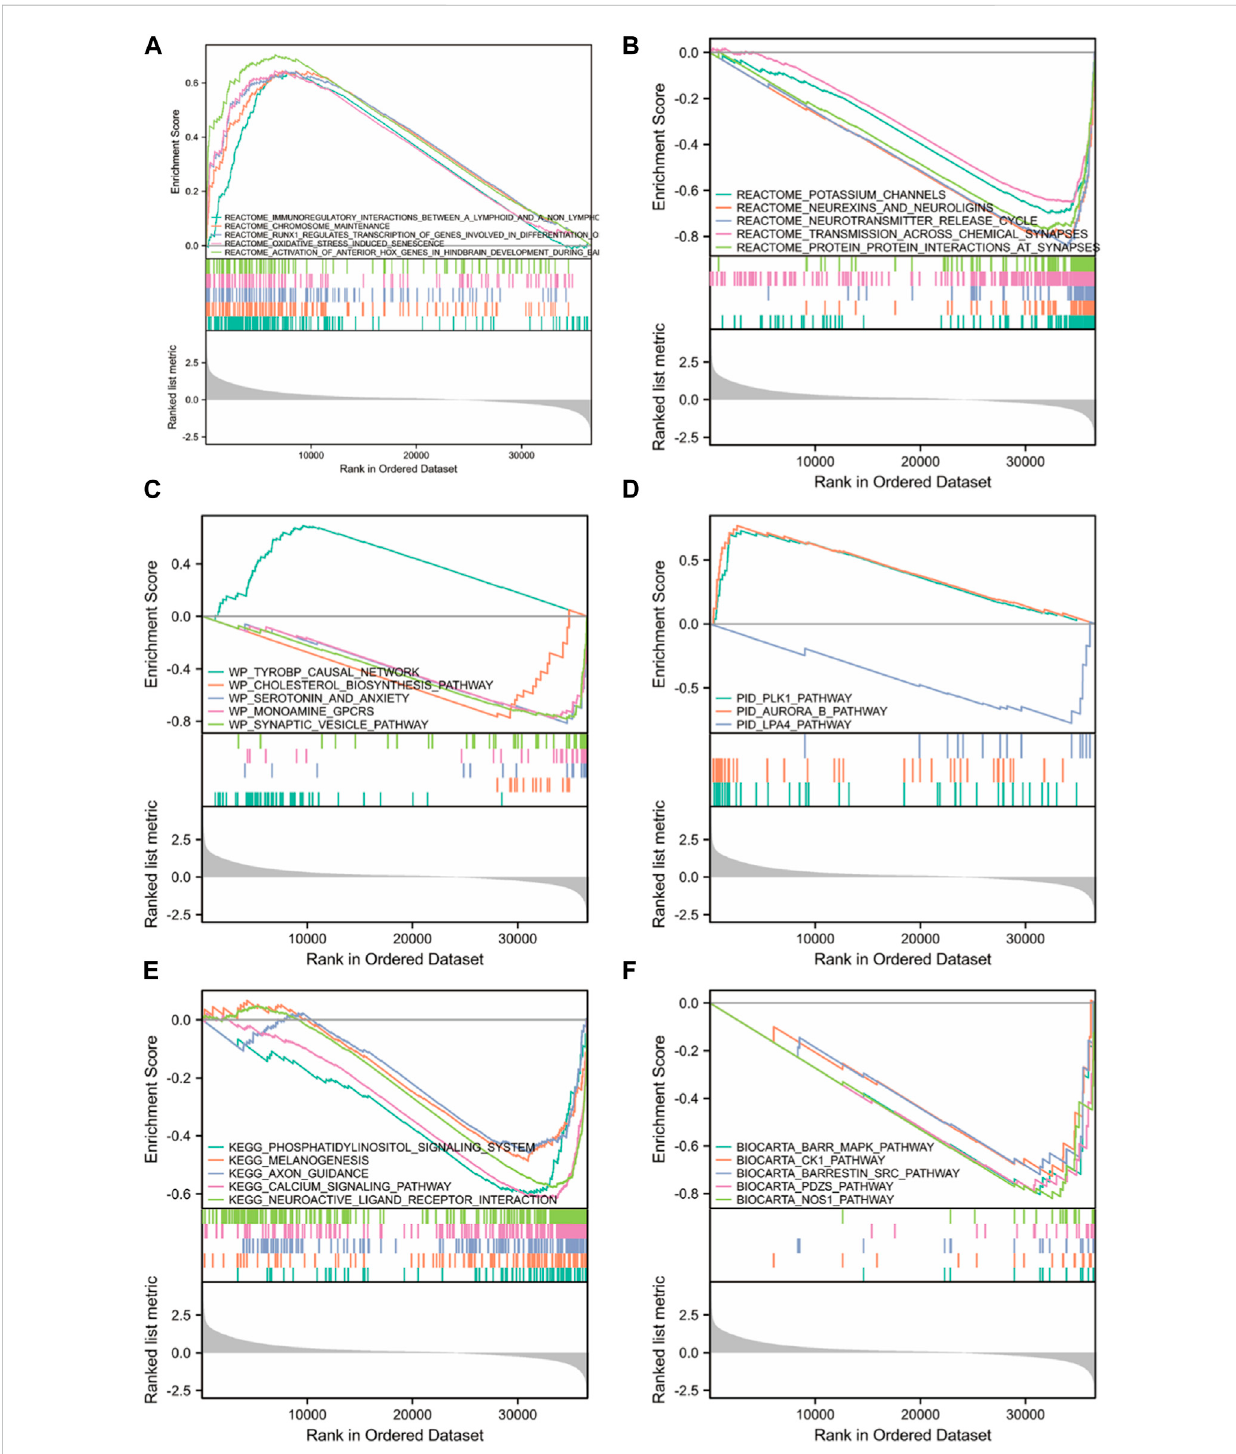
FIGURE 11 GSEA enrichment analysis between high and low FOXD3-AS1 expression groups. Signi fi cant enrichment entries were included in the REACTOME (A, B) , WP (C) , PID (D) , KEGG (E) , and BIOCARTA (F) databases, respectively.